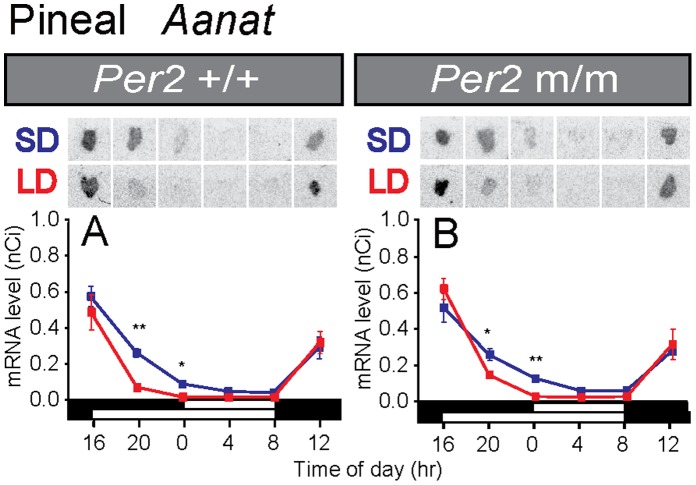
Temporal expression profiles of the Aanat gene in wild-type (A) and Per2 mutant mice (B) under short-day and long-day conditions.Data were replotted from Figure 3. The bars at the bottom of each graph represent the short-day (SD; blue) and long-day (LD; red) conditions. Representative autoradiograms of the pineal gland are also shown. *P<0.05, **P<0.01 LD vs. SD at the same time point (Student’s t-test), mean ± SEM (n = 4–5).